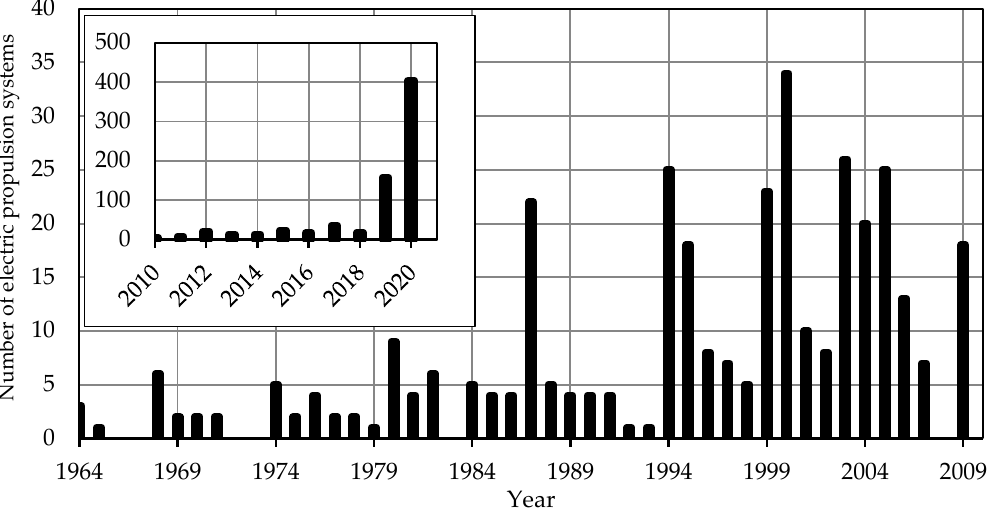
Figure 1. Approximate number of electric propulsion systems launched between July 1964 and March 2020 (enlarged view on the period 2010–2020). The graphic was computed based on Ref. [10] and data available online.